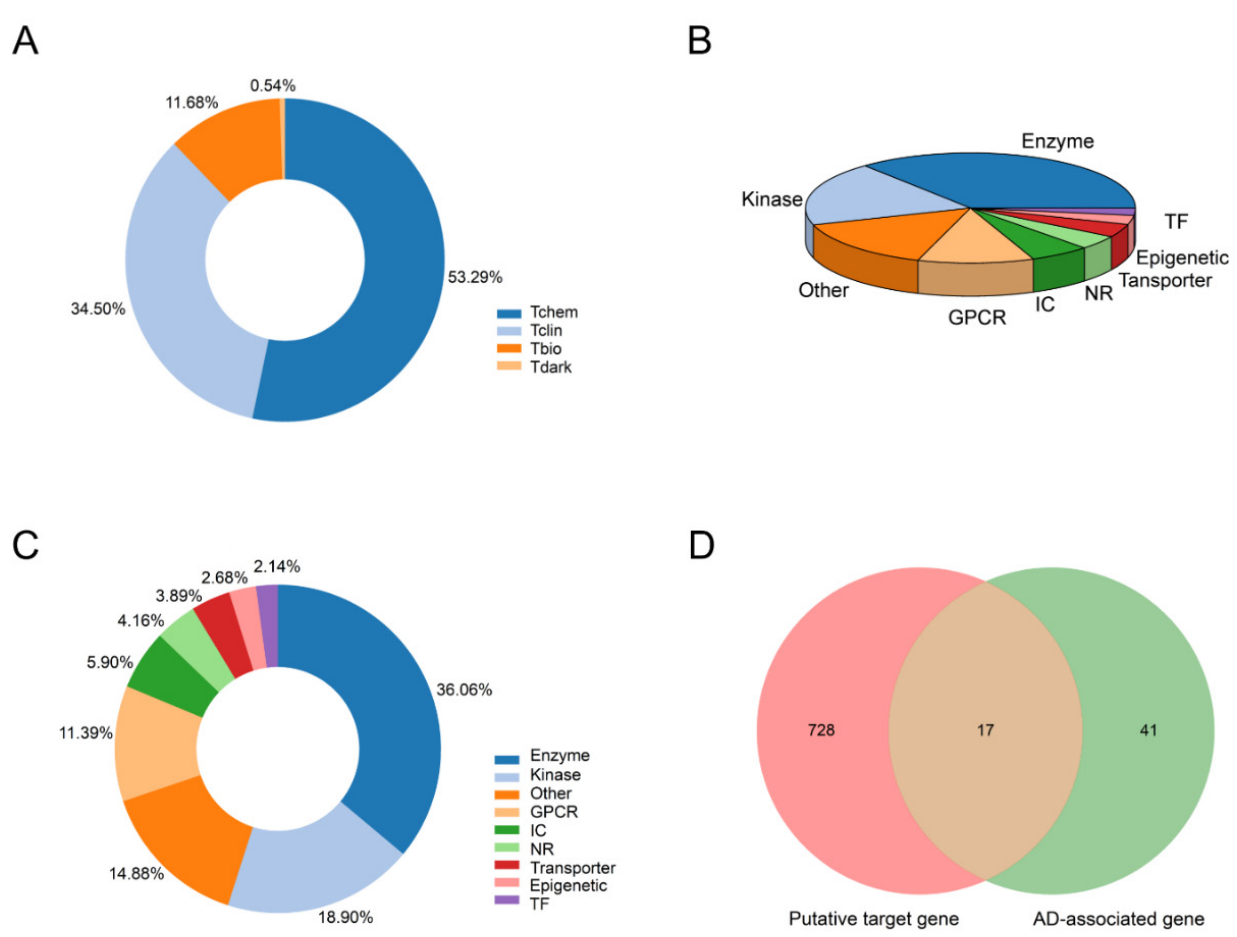
Figure 1. The putative target distribution of ( A ) target development/druggability levels; ( B ) target family in Tclin and ( C ) target family in all; ( D ) targets mapped to AD-related genes.